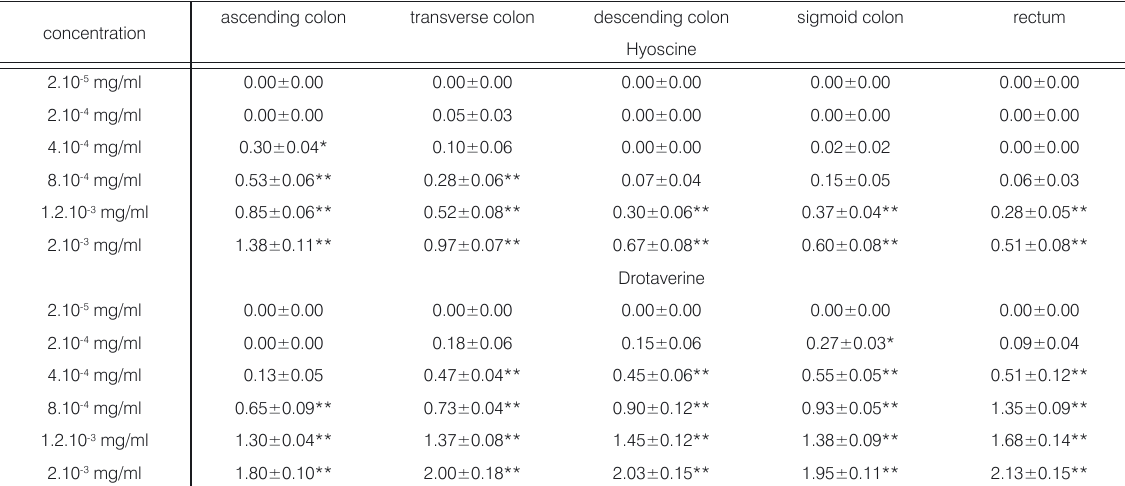
Table 4. Decrease of tone of SM preparations from the ascending colon, transverse colon, descending colon, sigmoid colon, and rectum, caused by hyoscine and drotaverine. The value of each relaxation caused by the different concentrations was compared to an effect of 0.00±0.00 mN for each of the areas of the colon individually. * P < 0.05; ** P <